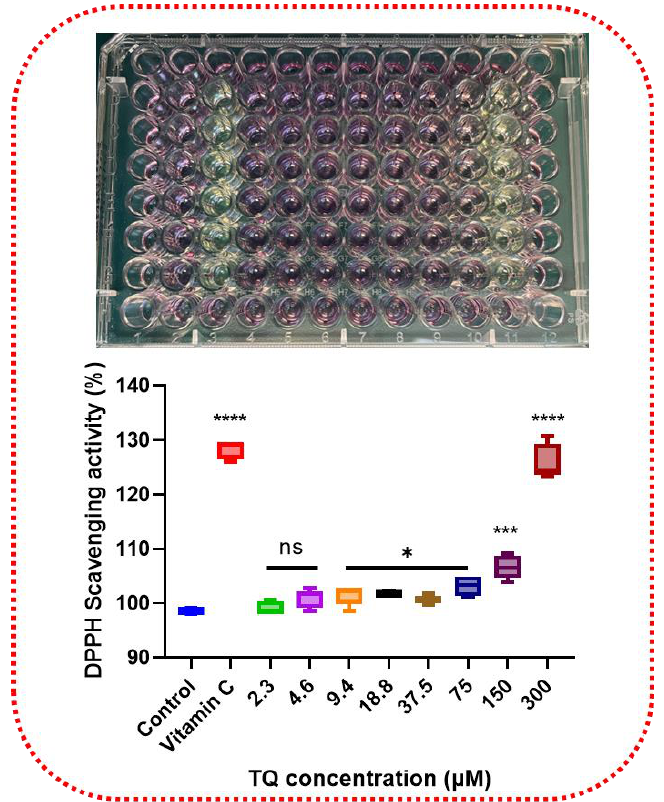
Figure 1. DPPH scavenging activity of TQ. The antioxidative capacities of TQ were determined by their capabilities to scavenge DPPH. DPPH was dissolved in DMSO and diluted in Methanol. TQ (0–300 μM) was reacted with DPPH. TQ scavenged DPPH in a concentration-dependent way in 30 min of reaction time. TQ was able to convert the stable radical DPPH to yellow diphenyl picrylhydrazine. Vitamin C was used as a positive control. Asterisks indicate a significant increment in DPPH scavenging activity compared with controls. Each bar indicates the mean ± SEM of three replications using one-way ANOVA followed by the Bonferroni test. statistical significance at * p ≤ 0.05, *** p < 0.001, **** p < 0.0001, ns non-significant. DPPH, 2,2-diphenyl-1-picrylhydrazyl; DMSO, dimethyl sulfoxide.